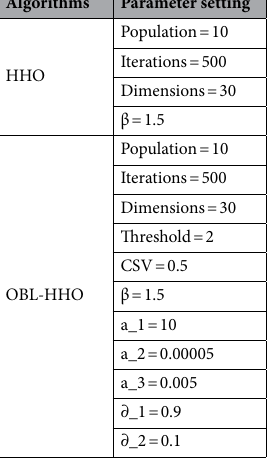
Table 2. Parameter settings for the variable in HHO and OBL-HHO.